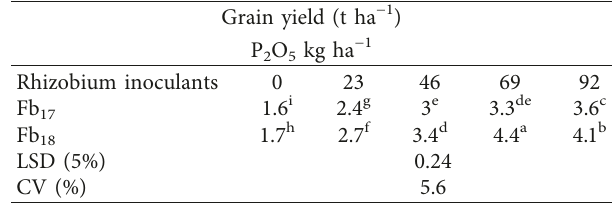
Table 14: Interaction effects of rhizobium inoculations and P fertilizer rate on grain yields.